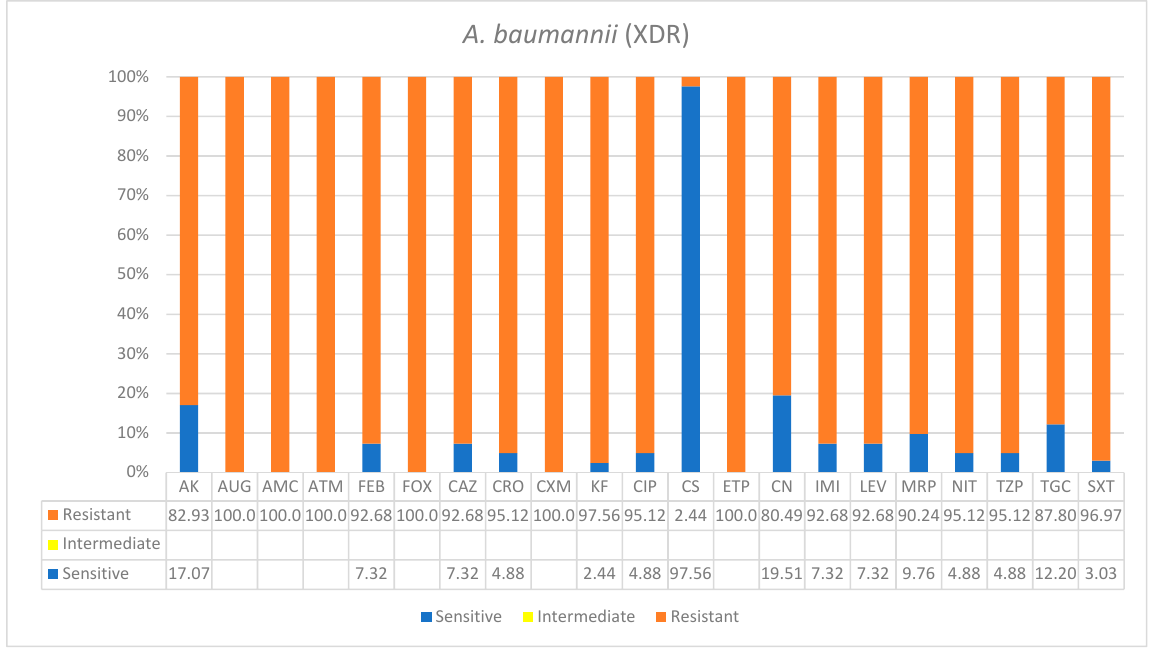
Figure 2. Antimicrobial sensitivity patterns of A.baumanii clinical isolates against 21 antibiotics. Abbreviations (in the order in which they appear in the figure): AK, amikacin; AUG, amoxicillin/clavulanic acid (2/1); AMC ampicillin; ATM, aztreonam; FEP, cefepime; FOX, cefoxitin; CAZ, ceftazidime; CRO, ceftriaxone CXM, cefuroxime; KF, cephalothin; CIP, ciprofloxacin; CS, colistin; ETP, ertapenem; CN, gentamicin; IMI, imipenem; LEV, levofloxacin; MRP, meropenem; NIT, nitrofurantoin; TZP, tazobactam; TGC, tigecycline; SXT, trimethoprim/sulfamethoxazole.